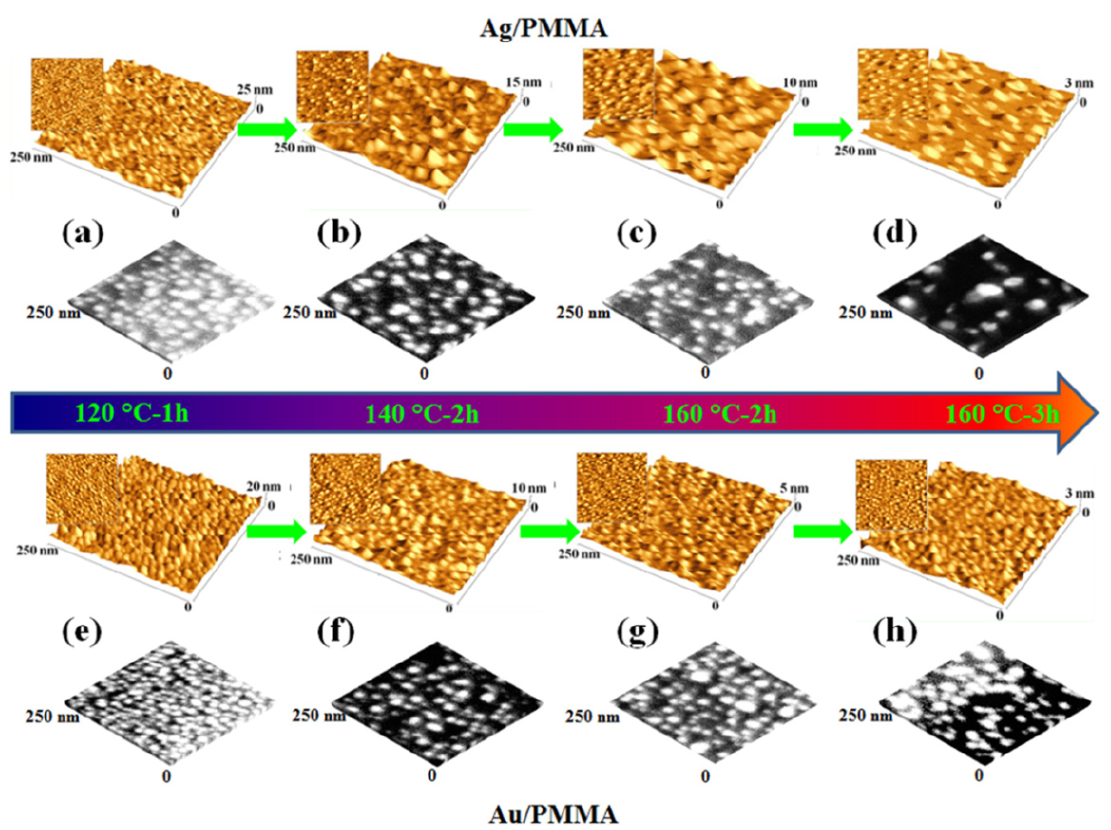
Figure 14. Representative two-dimensional, three-dimensional 0.25 μ m × 0.25 μ m AFM and SEM images of Ag ( a )–( d ) and Au ( e )–( h ) films deposited on PMMA and annealed for various temperatures and times. (Reproduced with permission from [65], Copyright Springer